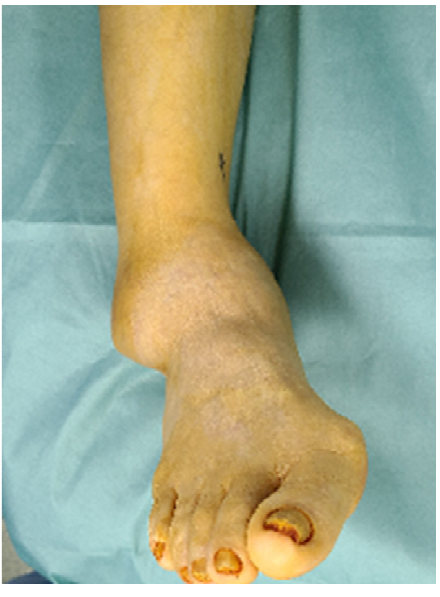
Figure 1. Gross photographs showing varus deformity of the ankle joint with swelling. Plain radiographs of the right ankle joint revealed that the medial malleolus was nearly absent in the right ankle joint on the anteroposterior view, and severe varus deformity was observed with osteoarthritic changes because of joint space destruction. The tibiotalar joint was destroyed in the lateral view, and the tibia was subluxed forward to the talus (Figure 2). A leg length discrepancy of approximately 3 cm was confirmed by a scanogram. A three-dimensional computed tomography (CT) scan also revealed severe destruction of the tibiotalar joint and varus deformation (Figure 3). Magnetic resonance imaging showed diffuse synovial thickening of the destroyed tibiotalar joint with joint effusion (Figure 4). Increased uptake along with the soft tissue around the ankle joint was detected on hybrid 99mTc white blood cell (WBC) single-photon emission computed tomography (SPECT)/CT, but uptake was generally low in the talocrural and subtalar joints (Figure 5). The complete blood count, erythrocyte sedimentation rate, and C-reactive protein level were normal, and there were no other specific clinical findings. Based on these results, we diagnosed the patient with sequelae of septic ankle